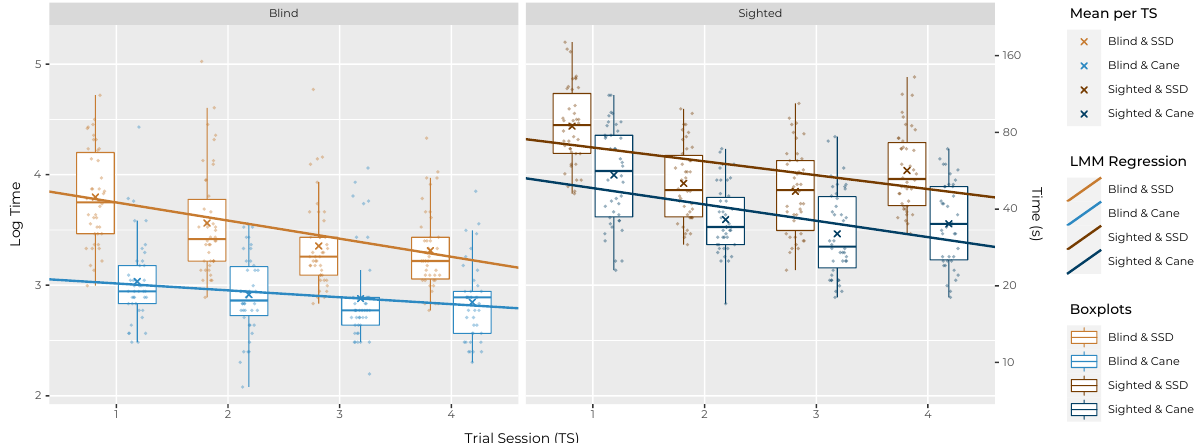
Figure 5. Trial session (TS) vs. normalised task completion time (log time) of all samples as boxplots, means and regression lines from the linear mixed model. Split horizontally by group (blind/sighted) and subdivided by aid in colour